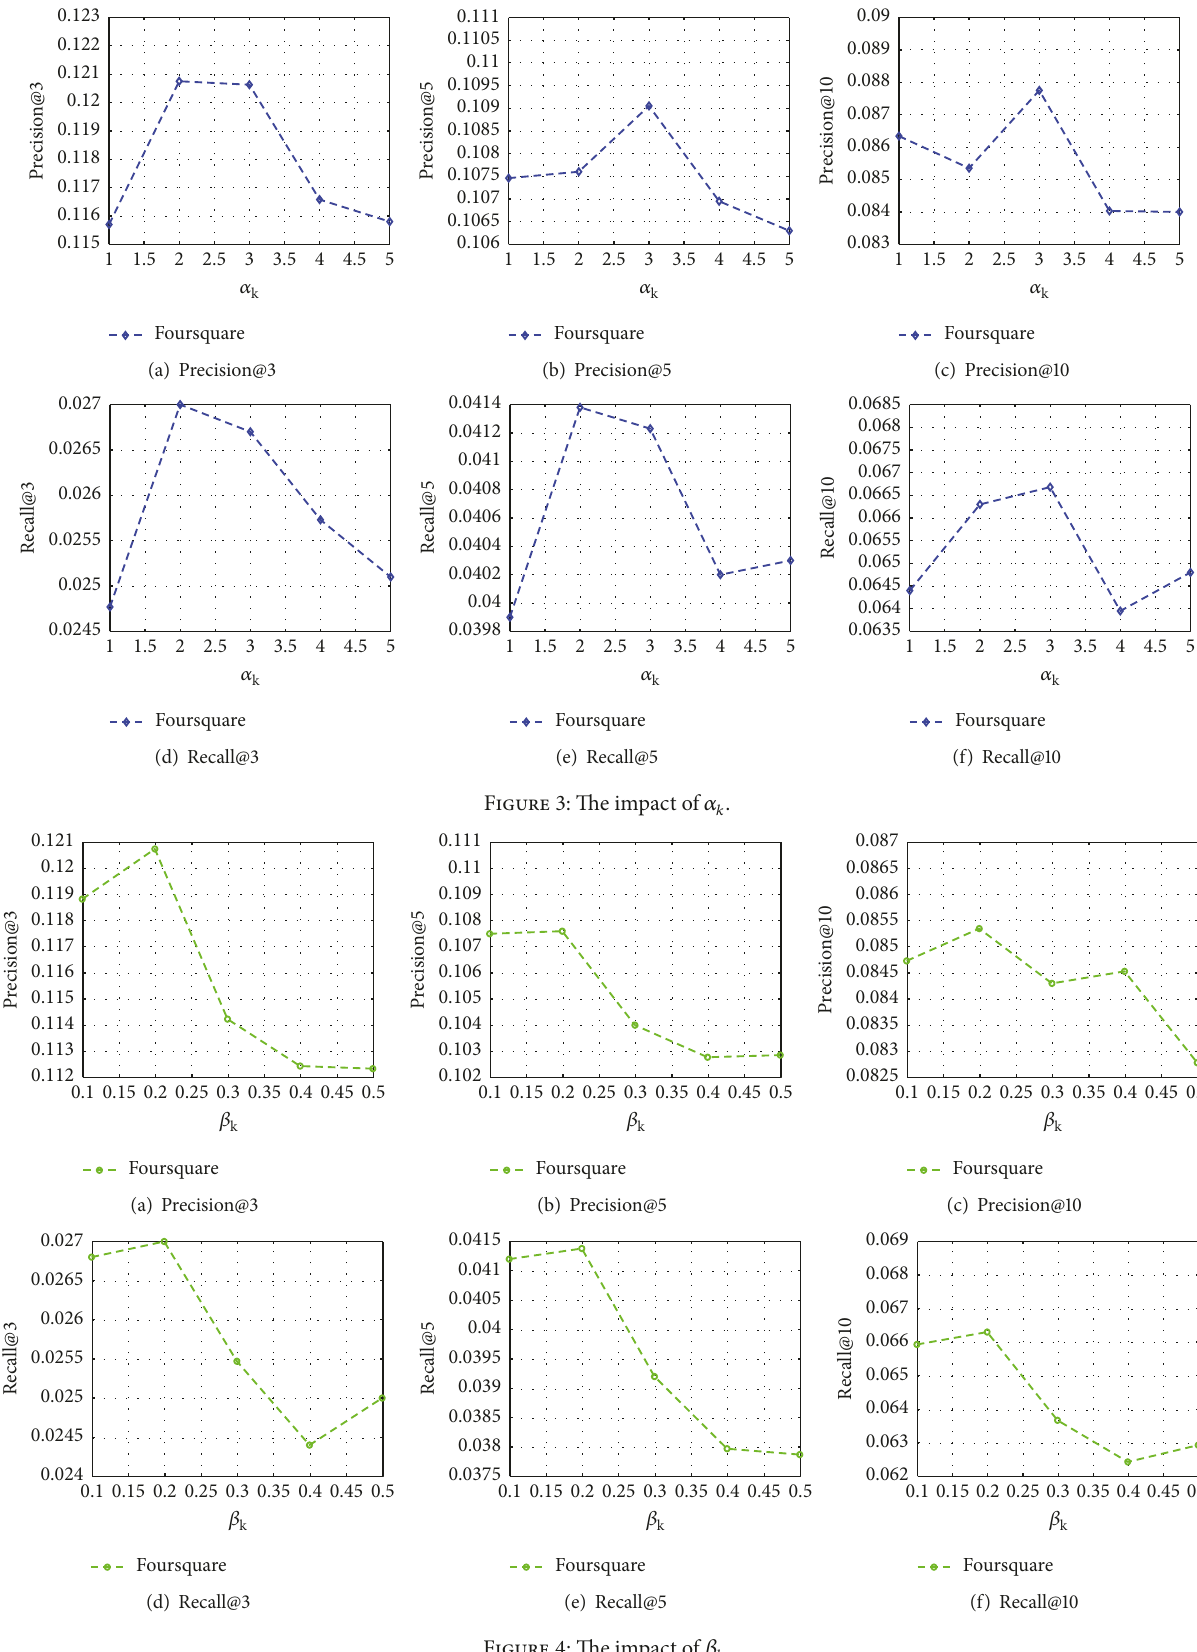
Figure 4: The impact of 𝛽 𝑘